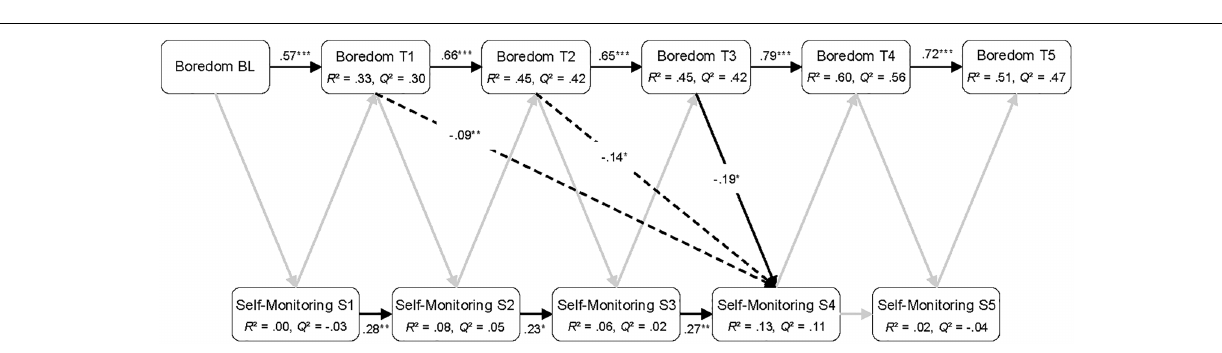
FIGURE 5 | Sequential PLS-PM analysis showing all direct and the significant indirect paths between boredom and self-monitoring. BL, baseline measurement; T1 to T5, five measurement occasions during playing Cure Runners ; S1 to S5, five sections of Cure Runners . Black lines, significant direct paths; gray lines, non-significant direct paths; dashed lines, significant indirect paths. n = 88. ∗ p < 0.05, ∗∗ p < 0.01, ∗∗∗ p <